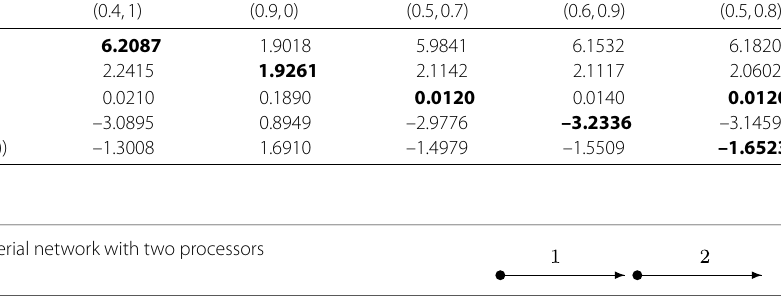
Figure 7 Serial network with two